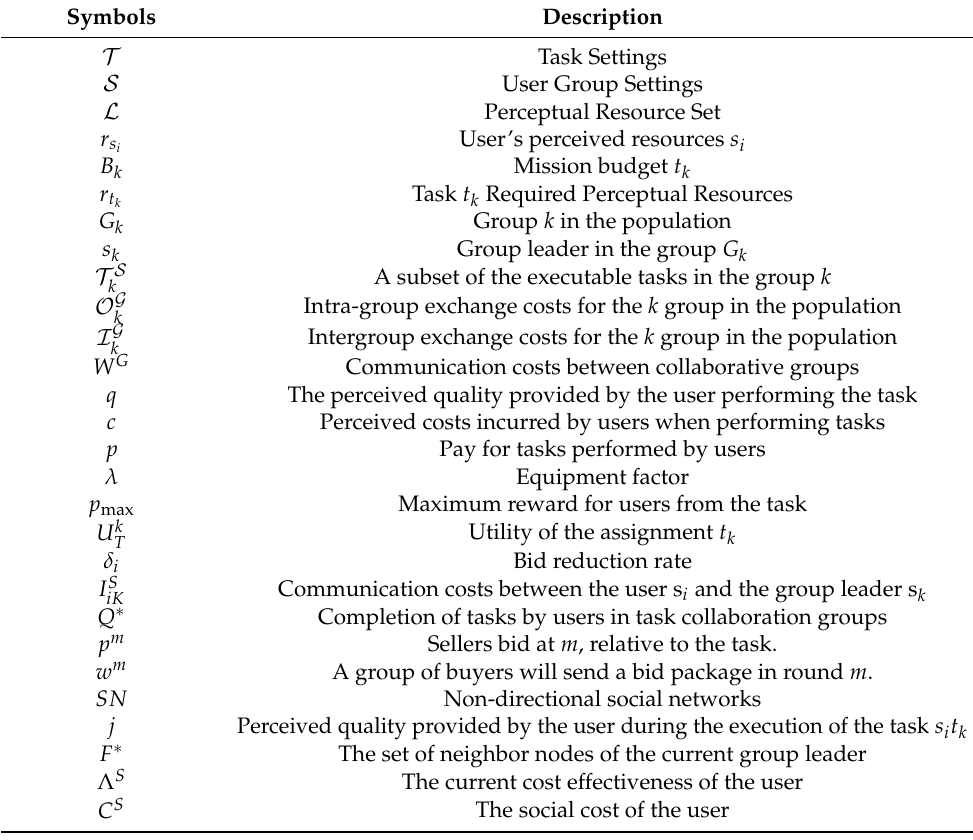
Table 1. Symbols of model